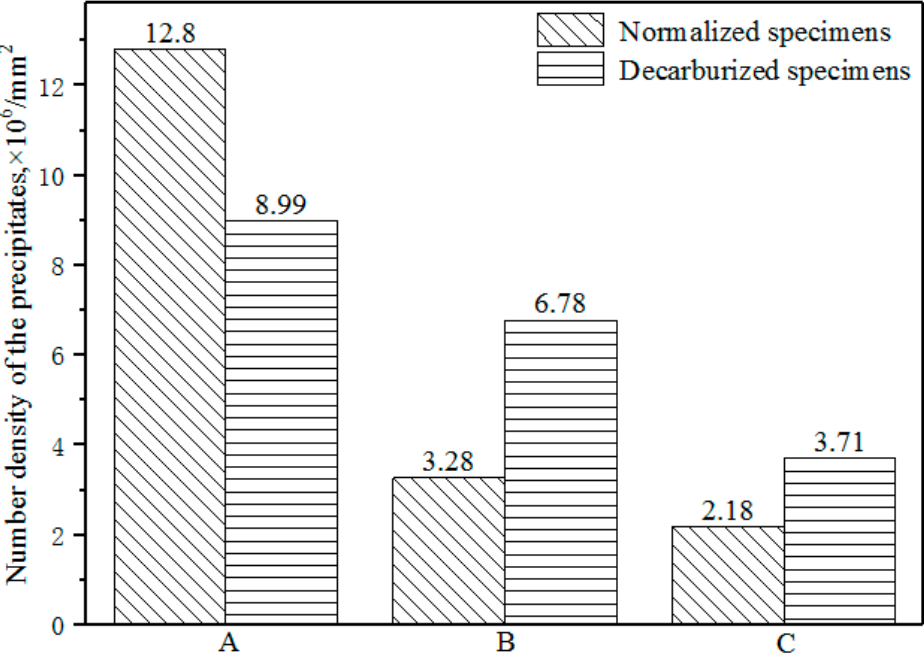
Figure 3. Number density of the precipitates in the specimens.